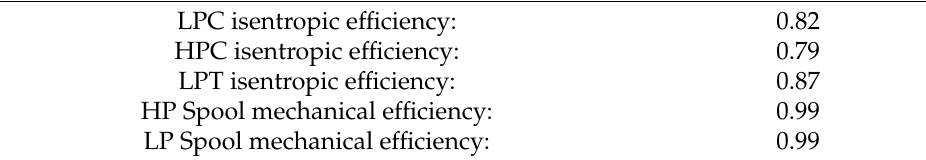
Table 3. Model Isentropic Efficiencies.